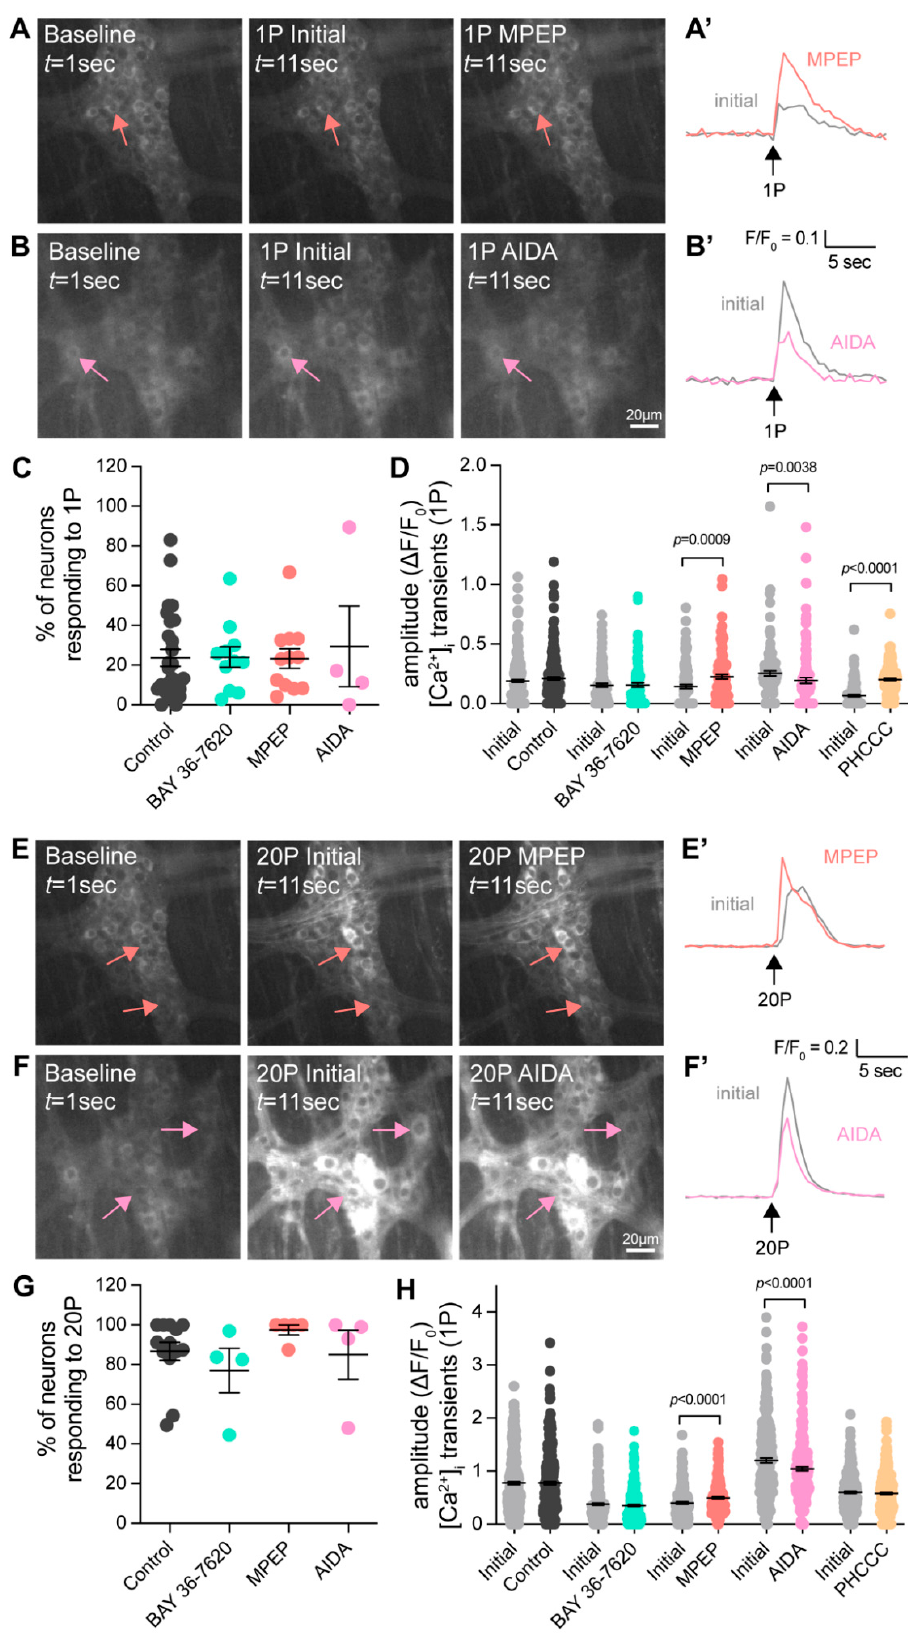
Figure 4. Effect of Group-I mGlu receptor antagonists on enteric neurotransmission following electrical stimulation. ( A , B ) Representative images of GCaMP6f fluorescence during live Ca 2+